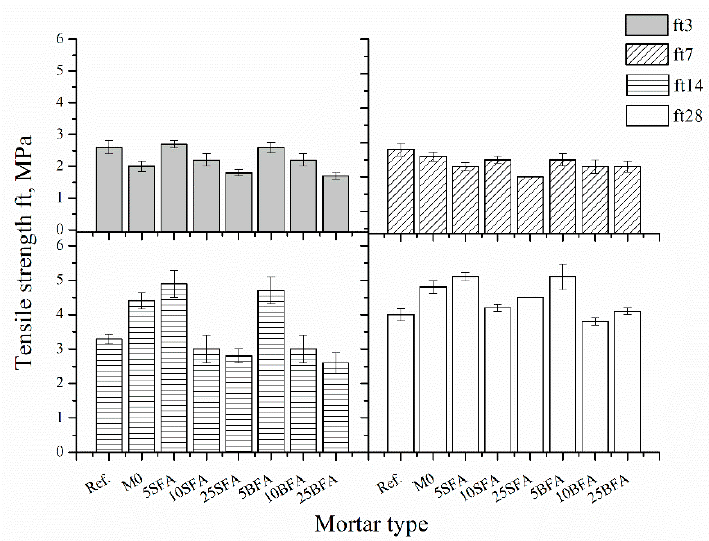
Figure 5. Tensile strength of tested mortars.